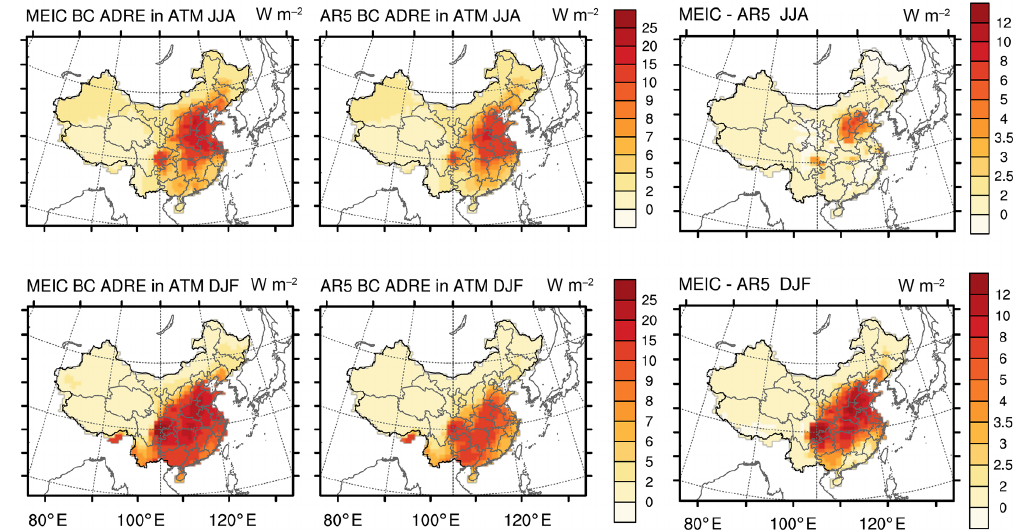
Figure 14. Same as Fig. 13 but for the ADREs of BC in the atmosphere